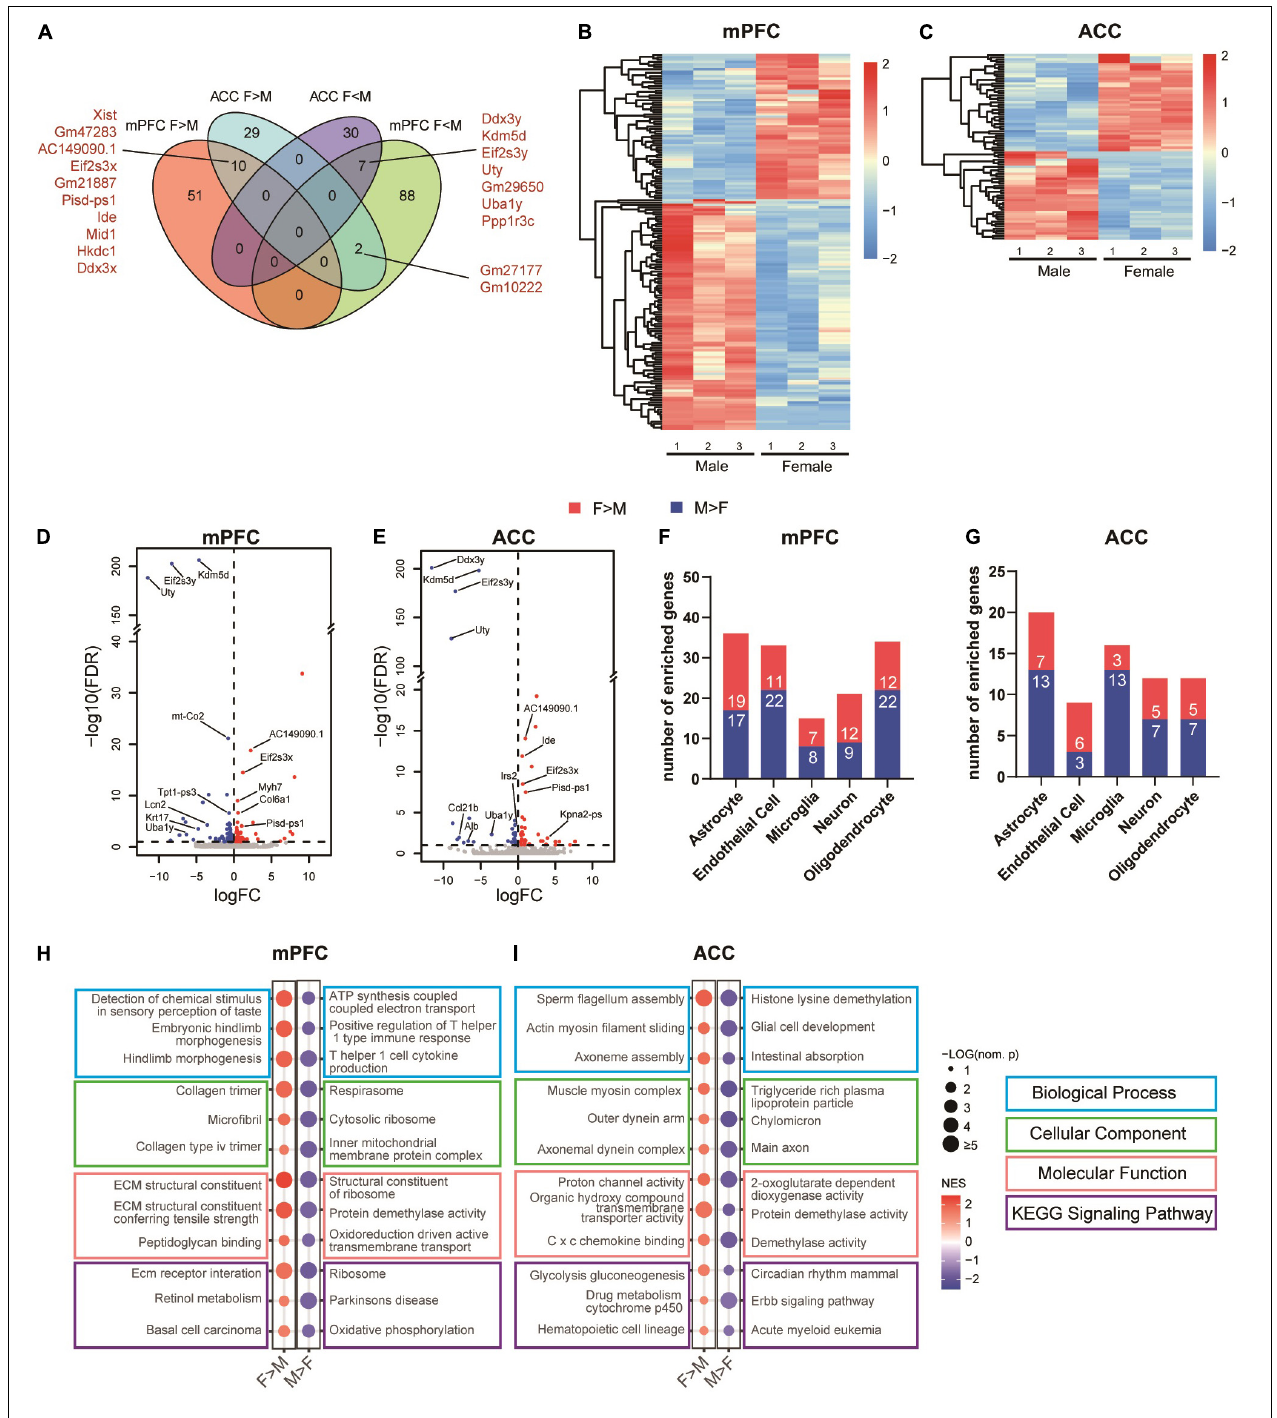
FIGURE 8 | Sex differences in the transcriptomic profiles of the mPFC and the ACC in the sham group. (A) Venn diagram depicting partial overlaps of the sex-specific DEGs between the mPFC and the ACC. F > M: transcripts expressed significantly more in the female than in the male mice; F < M: transcripts expressed significantly more in the male than in the female mice. Hierarchical clustered heatmaps showing relative expression of the sex-specific DEGs in the mPFC (B) and the ACC (C) from the sham group. Color scales represent standardized rlog-transformed values across samples. The volcano plots of the sex-specific DEGs in the mPFC (D) and the ACC (E) , with horizontal lines at the –log 10 (false discovery rate, FDR) = 1 and vertical lines at log 2 (fold change, FC) = 0. Blue dots represent transcripts expressed significantly more in the male than in the female mice, and the red dots represent transcripts expressed significantly more in the female than in the male mice. The numbers of specific DEGs enriched in different cell types in the mPFC (F) and the ACC (G) . Top sex-specific differentially enriched gene sets in the mPFC (H) and the ACC (I) . The size of the dots indicates the –log 10 (nominal p ) values, and the color indicates the normalized enrichment scores (NES).